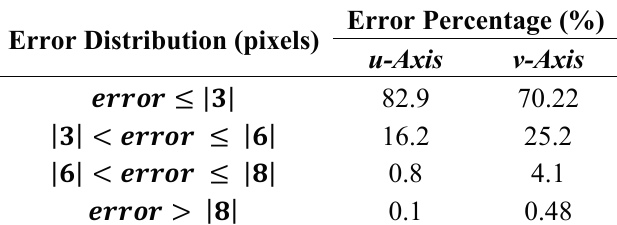
Table 2. Results of the error